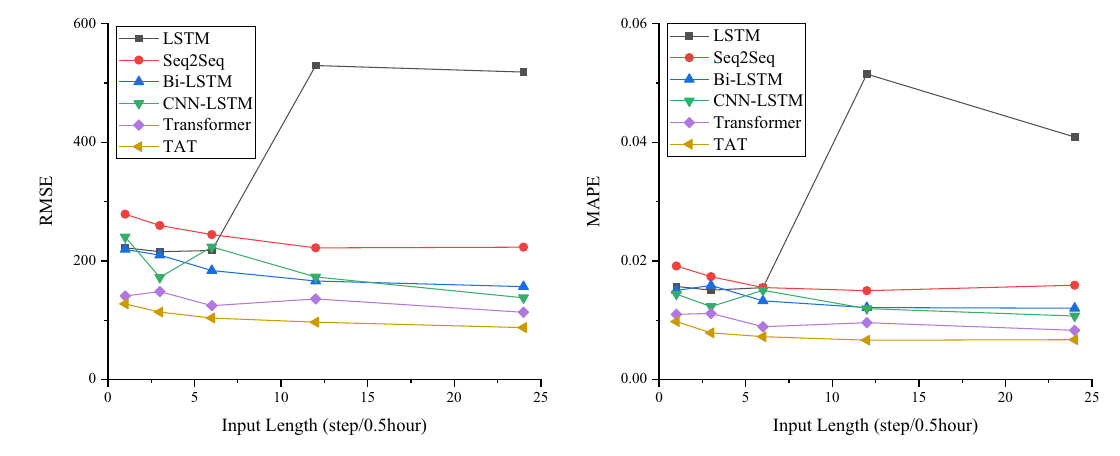
Fig. 6 The RMSE and MAPE of different input for an hour ahead